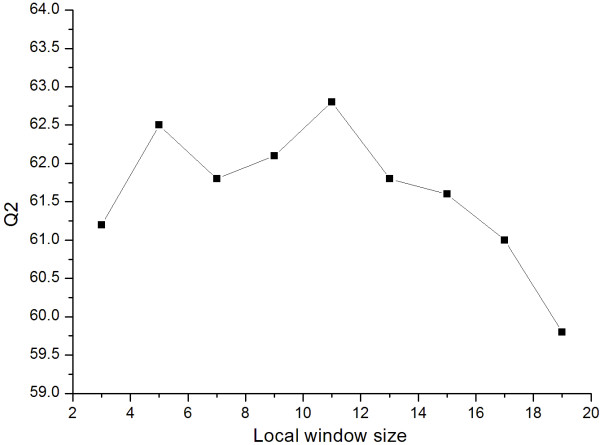
The prediction accuracy (Q2) using different local sequence window sizes. The local window size is defined as the residue numbers involved in the local sequence windows centered on proline.